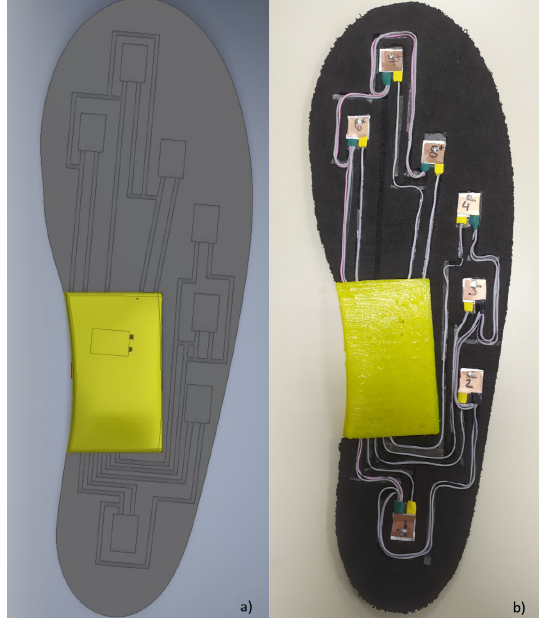
Figure 5. ( a ) 3D design of the insole in AutoDesk Inventor Professional 2018. ( b ) Inside view of the insole with custom-made capacitive sensors located at the main support plantar